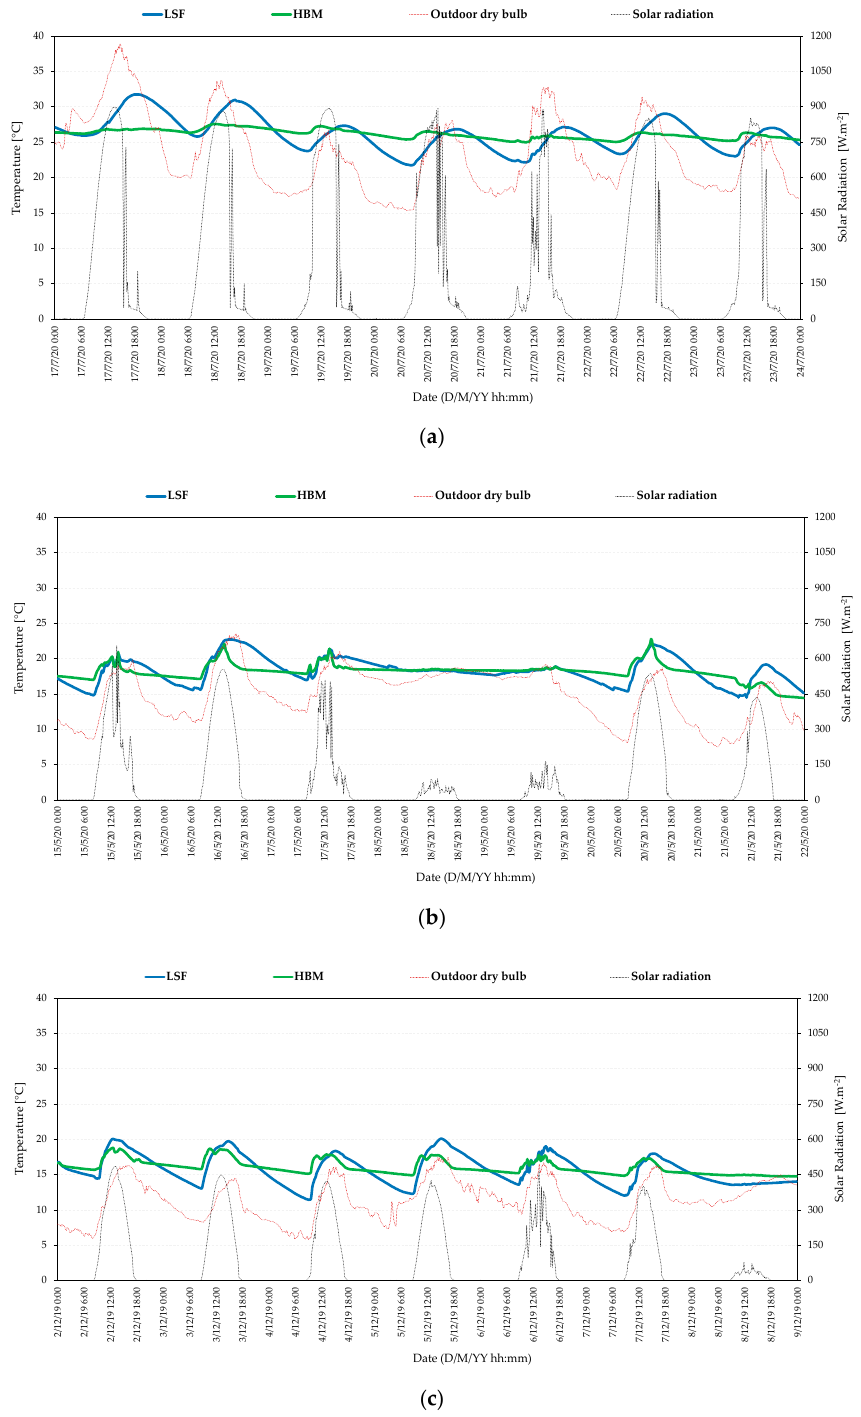
Figure 5. Indoor air temperature in the experimental test cells and outdoor environmental conditions during ( a ) summer week, ( b ) shoulder season week, and ( c ) winter week.